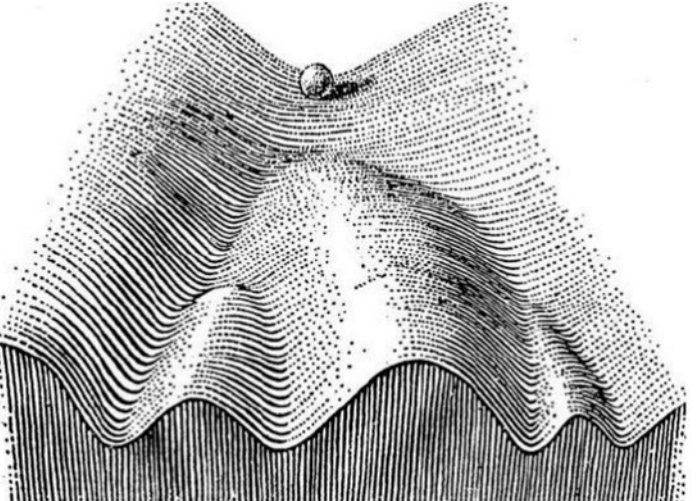
Figure 2. Schematic illustration of Waddington’s epigenetic landscape [35]. The ball rolling down the hill (the x axis) represents a pluripotent cell that differentiates as it rolls down the valleys. The fate of the cell is decided by the attractors that reside at the bottom of the hill (the y axis). The valleys are separated by ridges that preclude transdifferentiation [39].